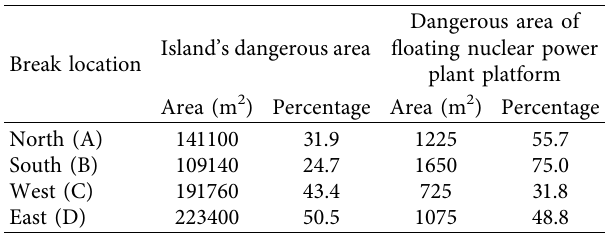
Table 3: The dangerous area and proportion after rotating at the northern